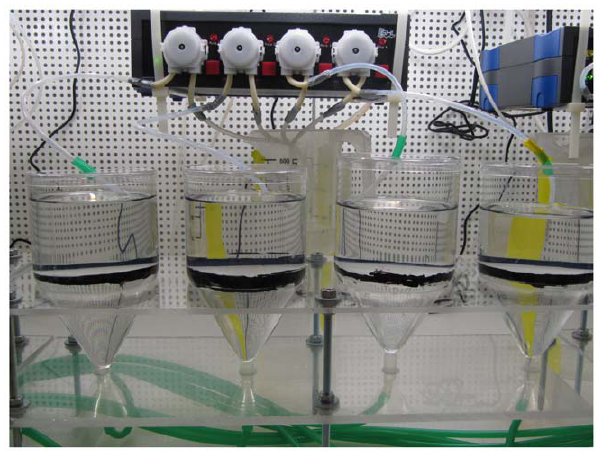
Figure 1. Scanning electron microscope image. An image of the size-homogenised, stable nTiO 2 suspension of the product P25 taken by an scanning electron microscope using 100,000-fold magnification (Hitachi SU8030).